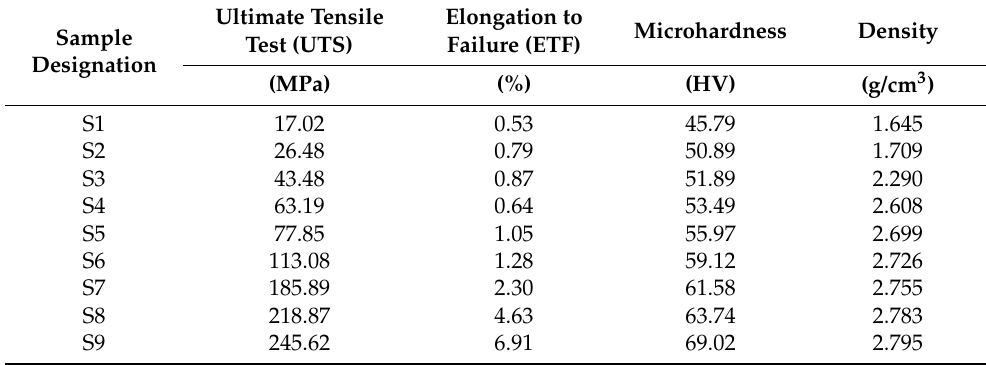
Table 4. Data responses at different operating temperatures and holding